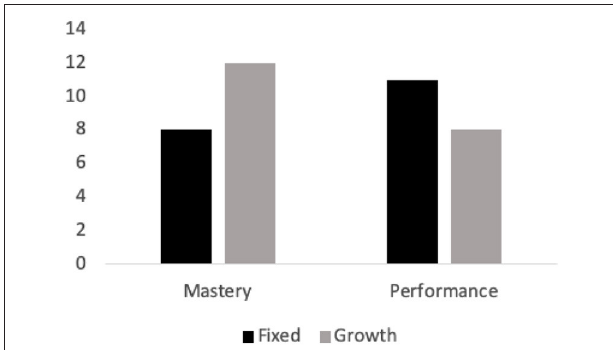
FIGURE 2 | Frequency of resilience statements across participants with growth vs. fixed